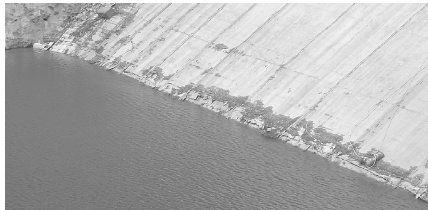
Figure 2: Image of slab cracks at Buxi Power